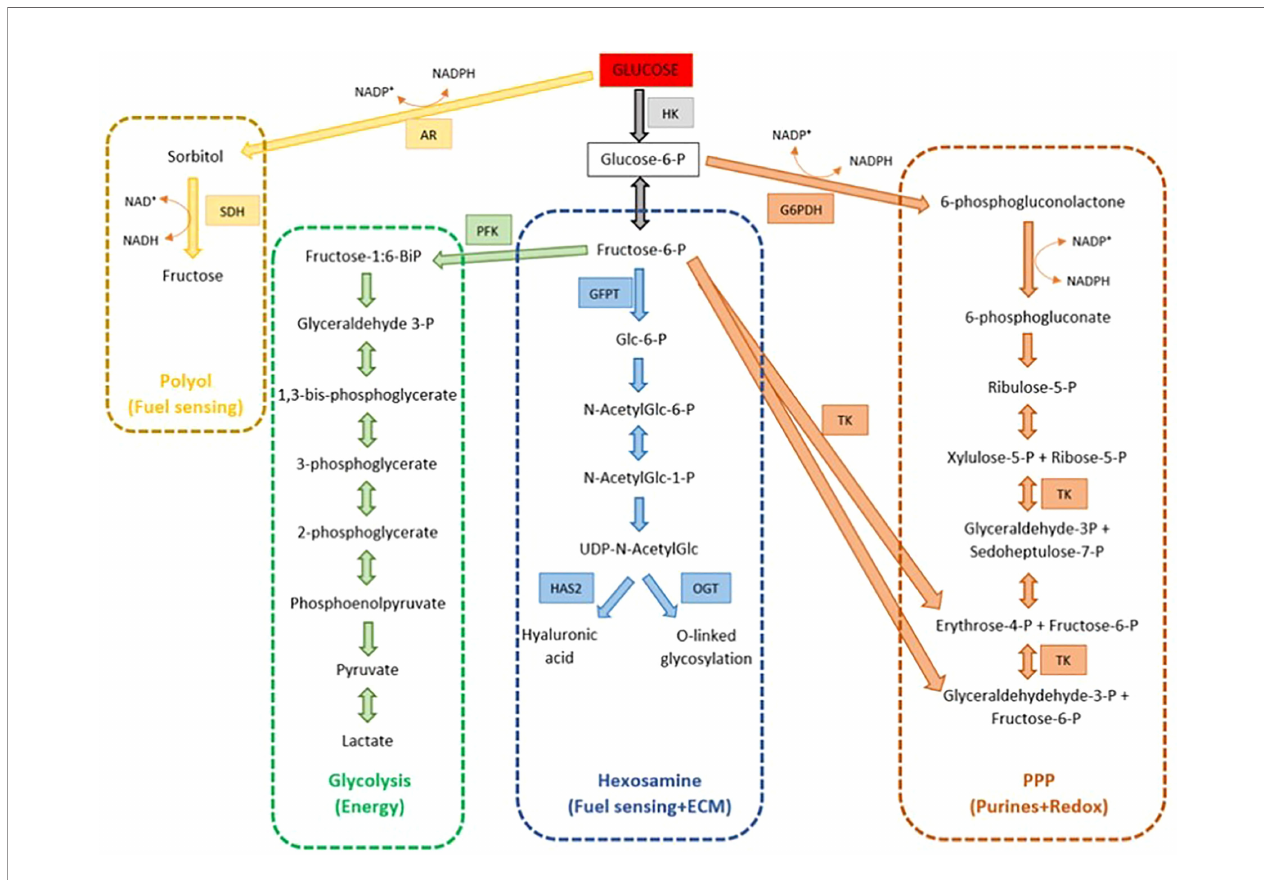
FIGURE 4 | Multiple glucose metabolism pathways within the cumulus-oocyte complex